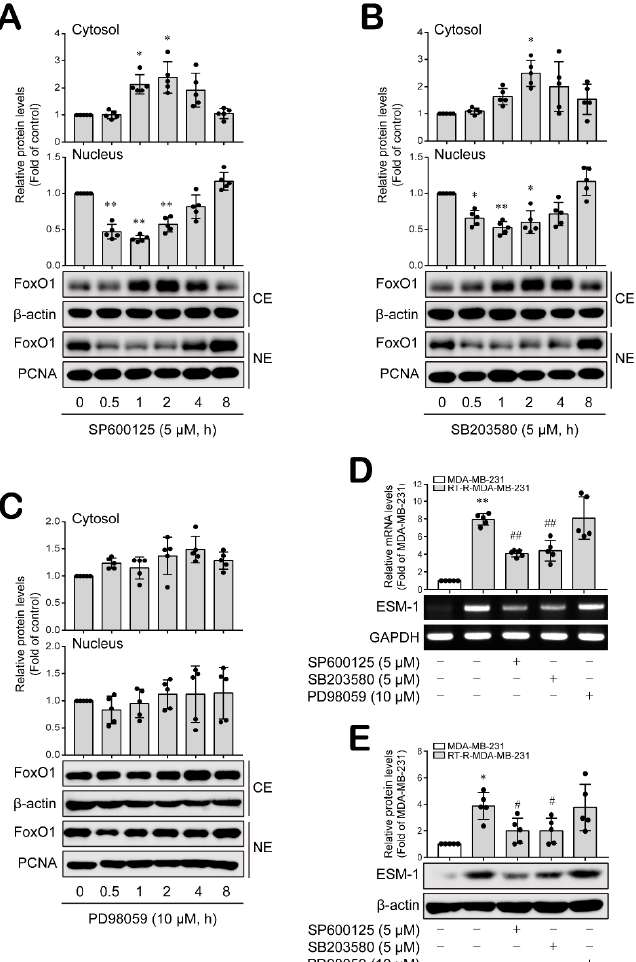
Figure 2. Nuclear FoxO1 levels and ESM-1 induction were mediated by JNK and P38 MAPK, but not ERK, in RT-R-TNBC cells. (A–C) RT-R-MDA-MB-231 cells were treated with SP600125 (5 µ M; a JNK inhibitor) ( A ), SB203580 (5 µ M; a p38 inhibitor) ( B ) and PD98059 (10 µ M; an ERK inhibitor) ( C ) for the indicated times, and nuclear/cytosolic protein was extracted from the cells. FoxO1 protein levels in the cytosol or nucleus were analyzed by Western blotting. β -Actin and PCNA were used as loading controls. The results are presented as the mean ± SD of five independent experiments. * p < 0.05, ** p < 0.01 compared to the control. CE, cytosolic extract; NE, nuclear extract. ( D , E ) MDA-MB-231 and RT-R-MDA-MB-231 cells were treated with the indicated inhibitors for 8 h or 16 h, and then total RNA or protein was collected from the cells. ESM-1 and GAPDH mRNA levels were analyzed by RT–PCR ( D ). ESM-1 and β -actin protein levels were analyzed by Western blotting ( E ). The values are presented as the mean ± SD of five independent experiments. * p < 0.05, ** p < 0.01 compared to the MDA-MB-231 cells; # p < 0.05, ## p < 0.01 compared to the untreated RT-R-MDA-MB-231